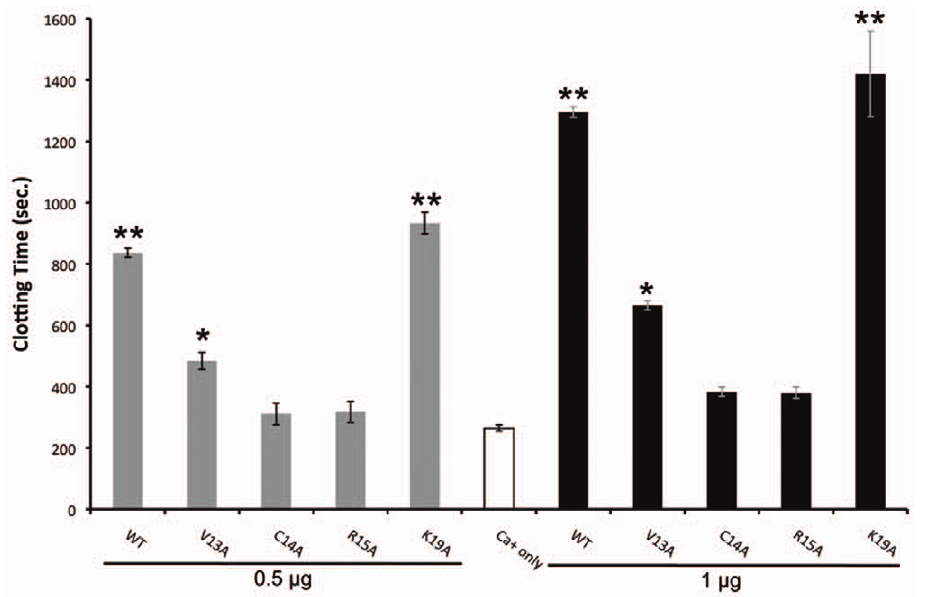
Figure 4. Point mutations in the reactive site loop of rSimulkunin disable anti-coagulation activity. Each recombinant protein was tested by adding 0.5 m g (grey bars) or 1 m g (black bars) to a fixed volume of plasma. Plasma was then pre-warmed at 37 u C for 15 min before addition of 25 mM (8.3 mM final concentration) CaCl 2 (pre-warmed) to initiate clotting. White bar shows the Ca 2 + -only plasma control. The graph shows mean 6 SD from three independently conducted experiments. p -values for significant differences by one-tailed t-test are shown, where the alternative hypothesis is that sample recalcification time is greater than the Ca 2 + -only control. Statistically significant increases in clotting time at p , 0.05 and p , 0.01 are indicated by * and ** respectively.